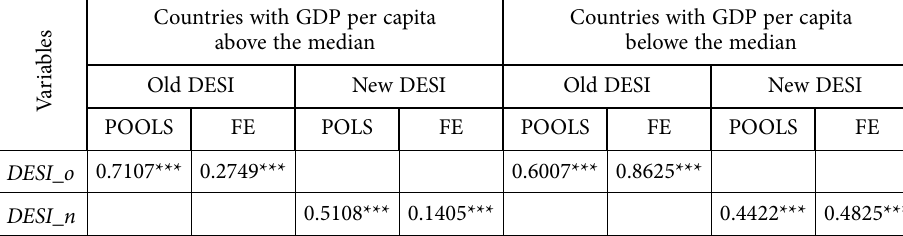
Table 6. GDP per capita estimates 2015–2019 – above and below median GDP per capita